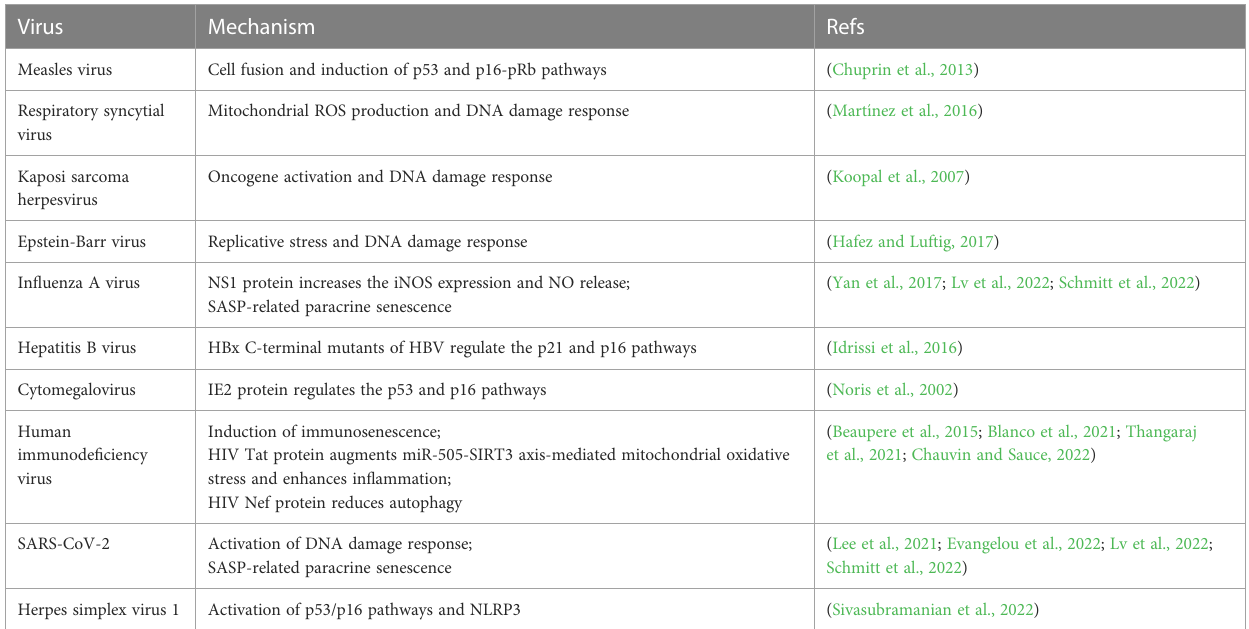
TABLE 1 Virus-induced senescence and potential